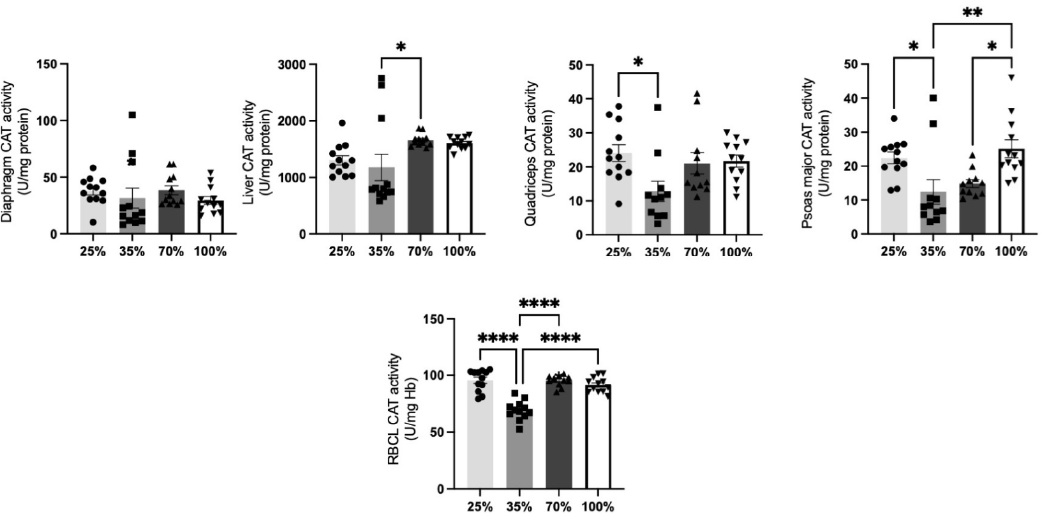
Figure 3. CAT activity levels at all 4 d.s. of kids. * denotes significant difference with p < 0.05, ** denotes significant difference with p < 0.01. **** denotes significant difference with p < 0.0001